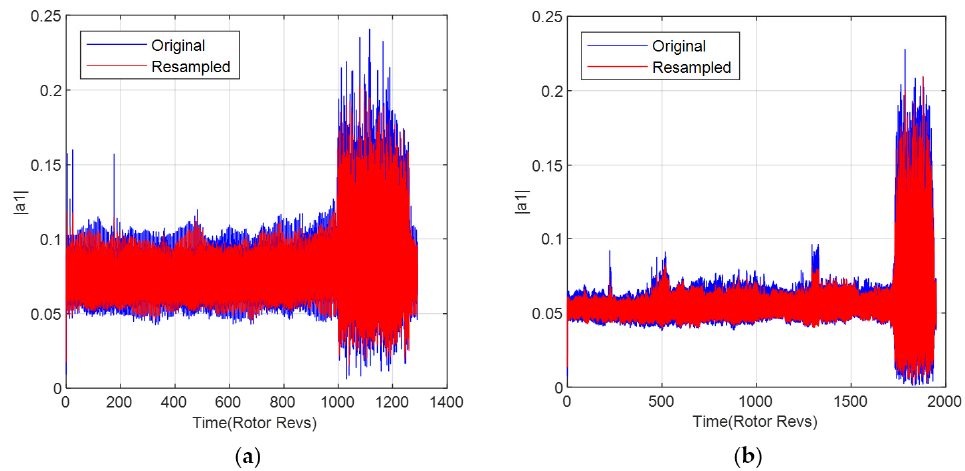
Figure 2. Amplitudes of spatial mode with pre-sampling and post-sampling: ( a ) Amplitudes at 2500 rpm; ( b ) Amplitudes at 3000